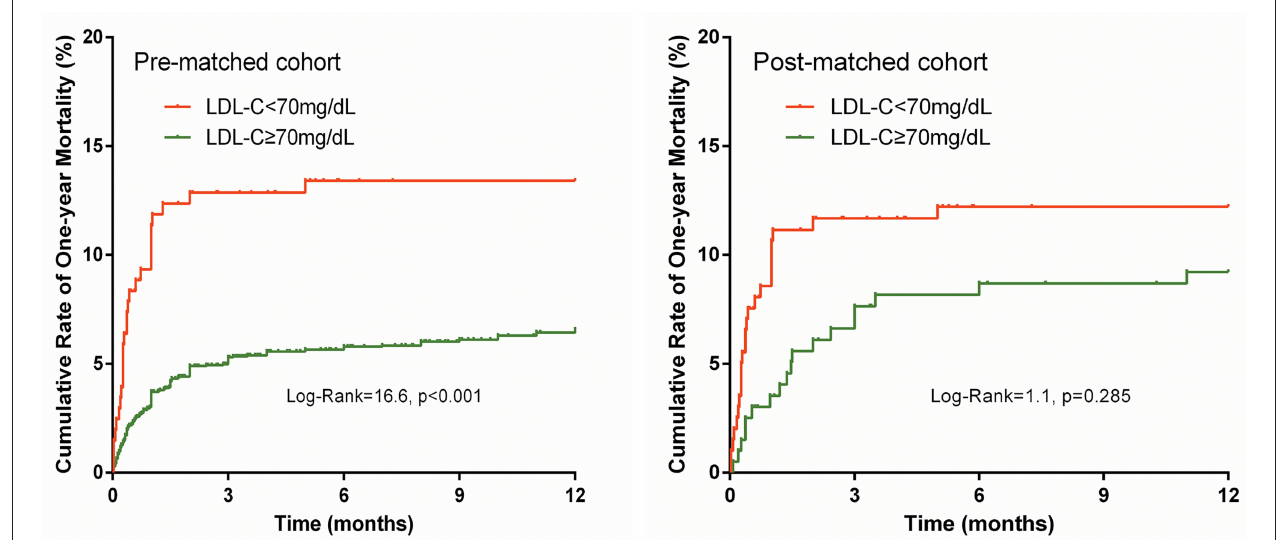
FIGURE 2 | Cumulative incidence curves for one-year mortality.